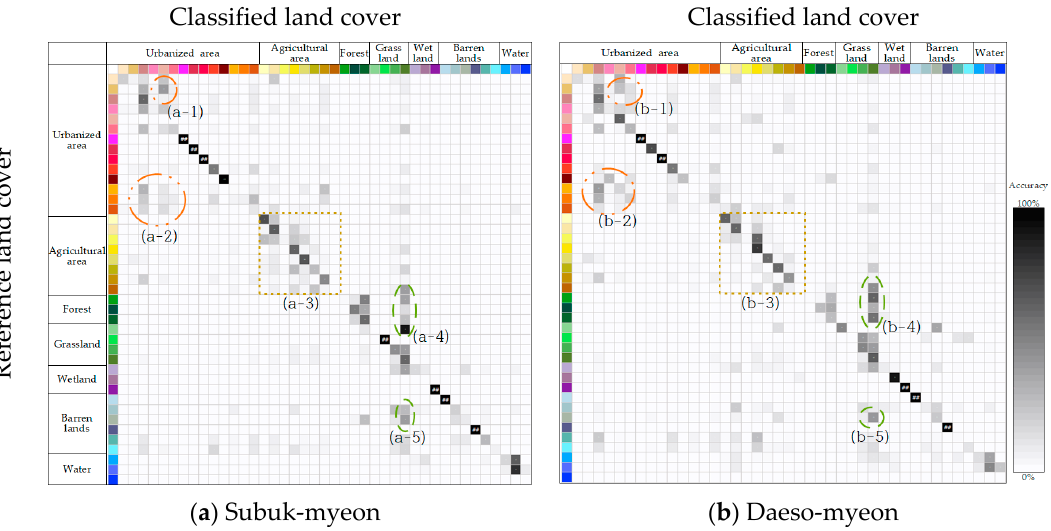
Figure 6. Model performance matrices for ( a ) the Subuk-myeon and ( b ) Daeso-myeon areas. The accuracy was presented in gray scale based on the percentage of the classified pixels that batch with the reference land cover label to the total number of pixels. The darker gray indicates the more pixels were classified to the given land cover. Refer to the color codes for detailed land cover given Table 1.